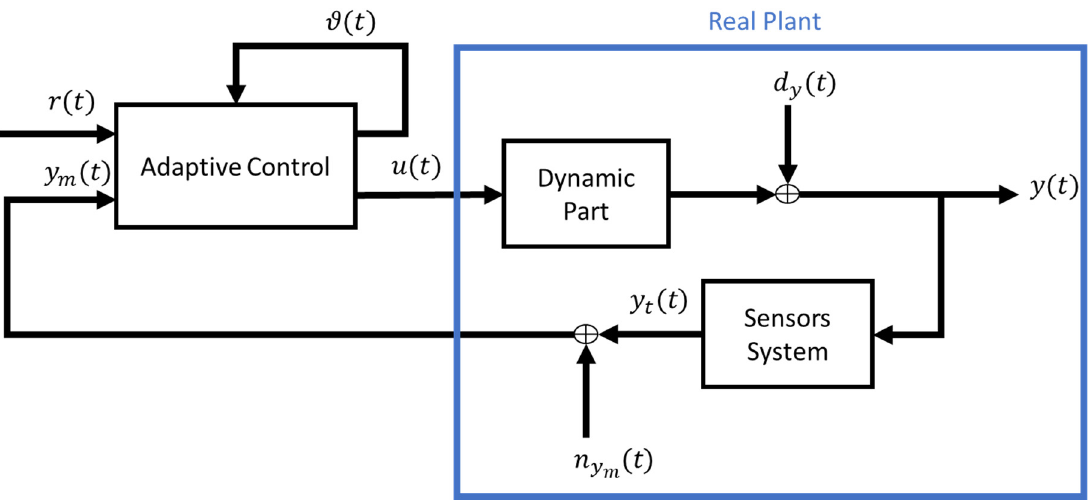
Figure 1. Schematic representation of the high-level Architecture of the proposed method.